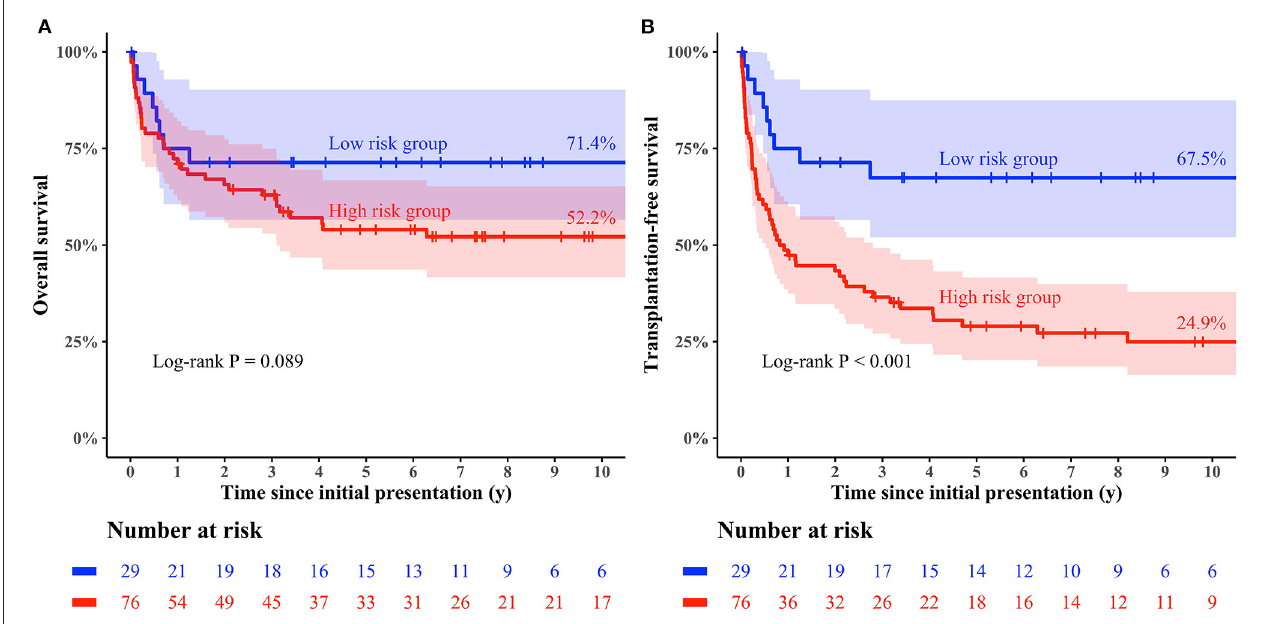
FIGURE 9 | Kaplan–Meier curves for clinical outcomes stratified by risk groups (A) overall survival, (B) transplantation-free